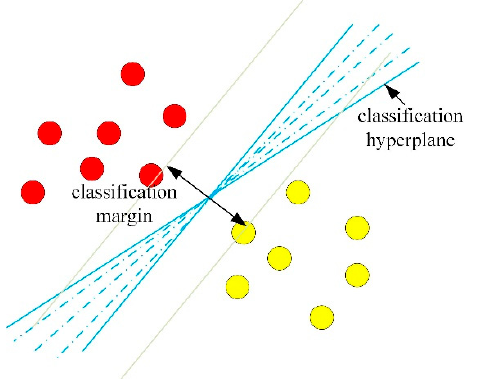
Figure 3. Illustration of classification hyperplane defined by rank-1 projection tensor and rank- R projection tensor. The bule solid line denotes the hyperplane defined by rank-1 or rank- R tensor, and the blue dotted line denotes the hyperplane defined by rank- R tensor.